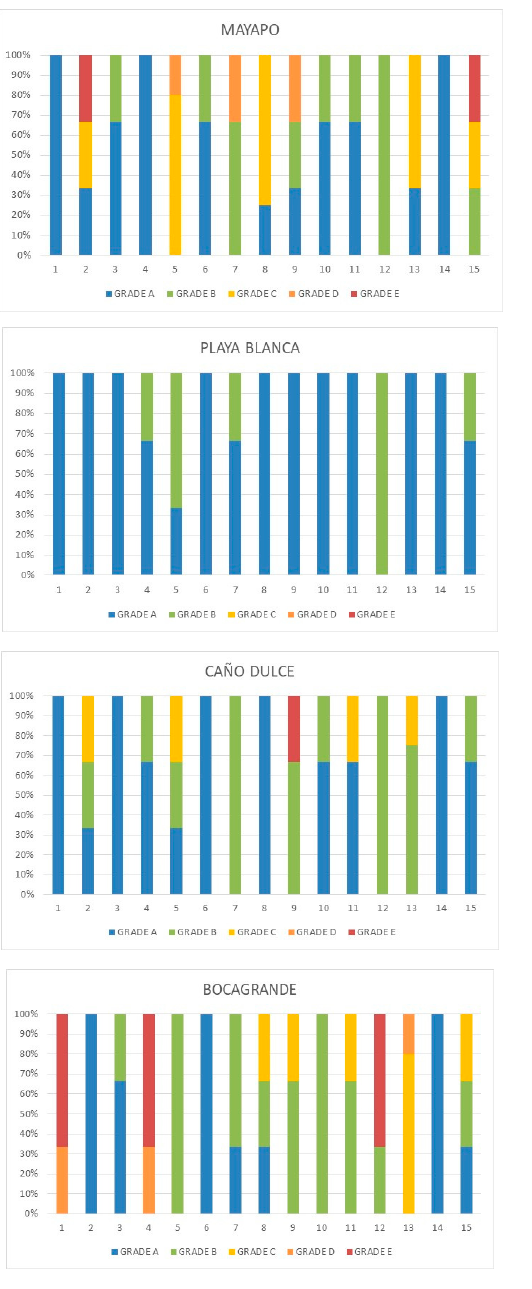
Figure 7. Application of the qualitative results of the BLAT-QQ technique.